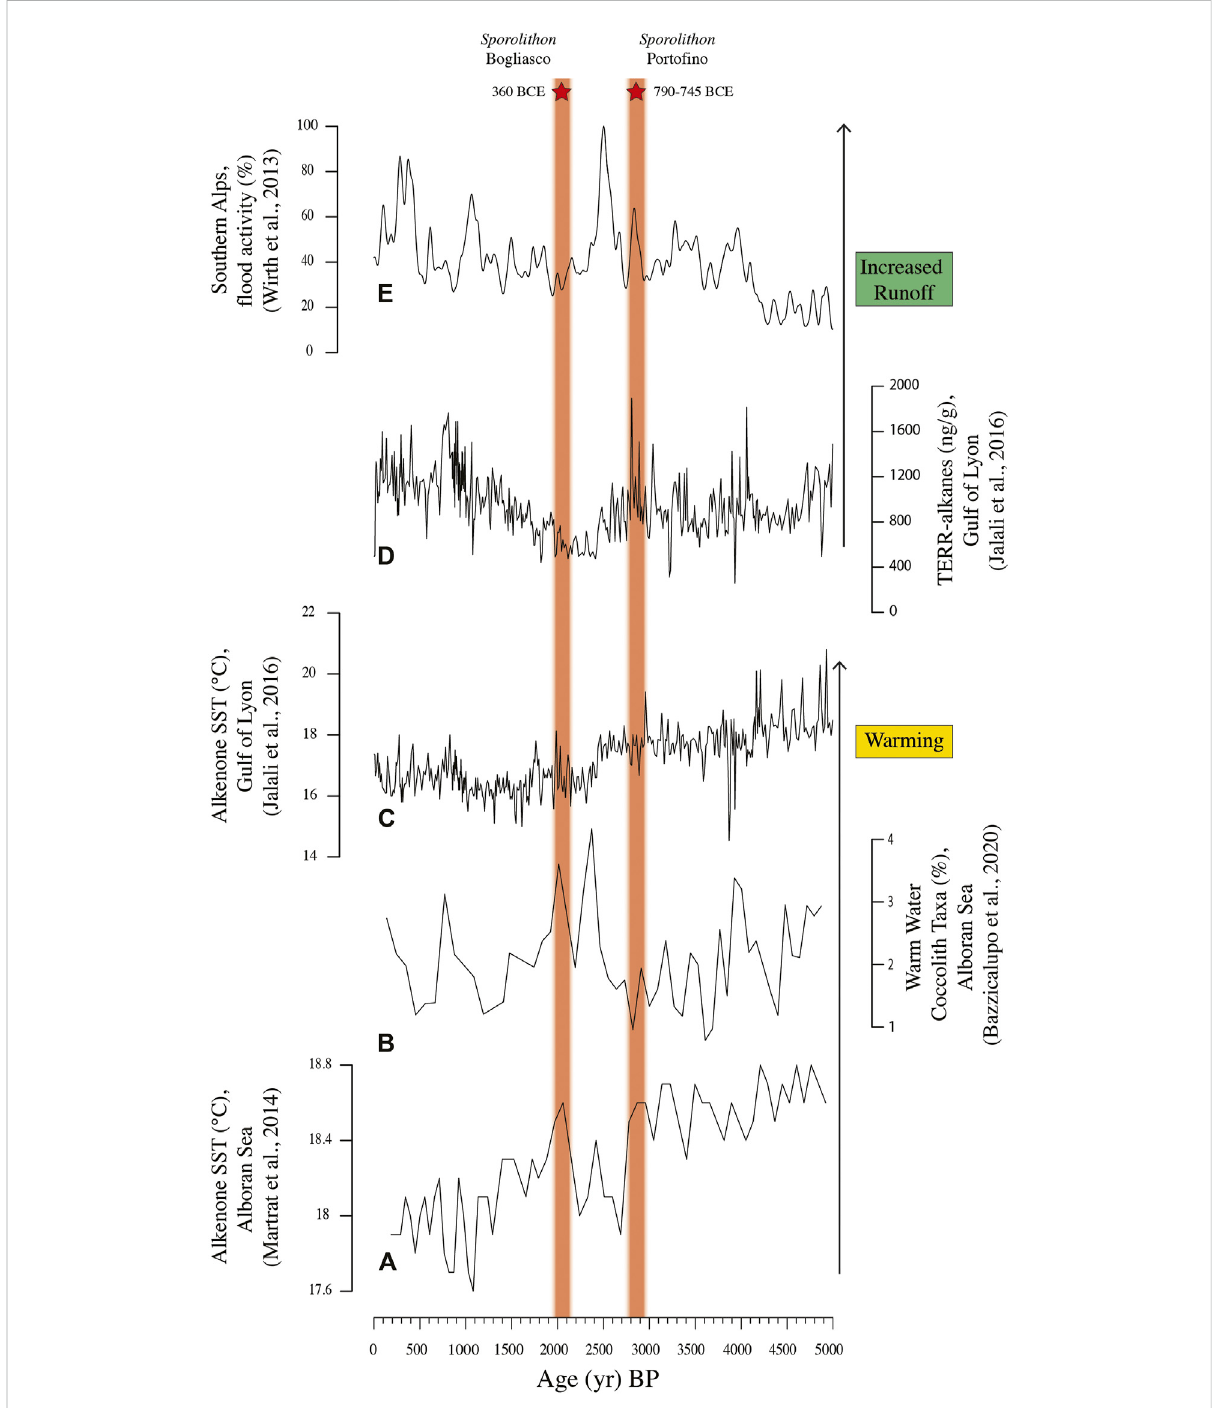
FIGURE 10 Late Holocene climate fl uctuations and the stratigraphic position of the Sporolithon occurrences recorded in the Porto fi no and Bogliasco